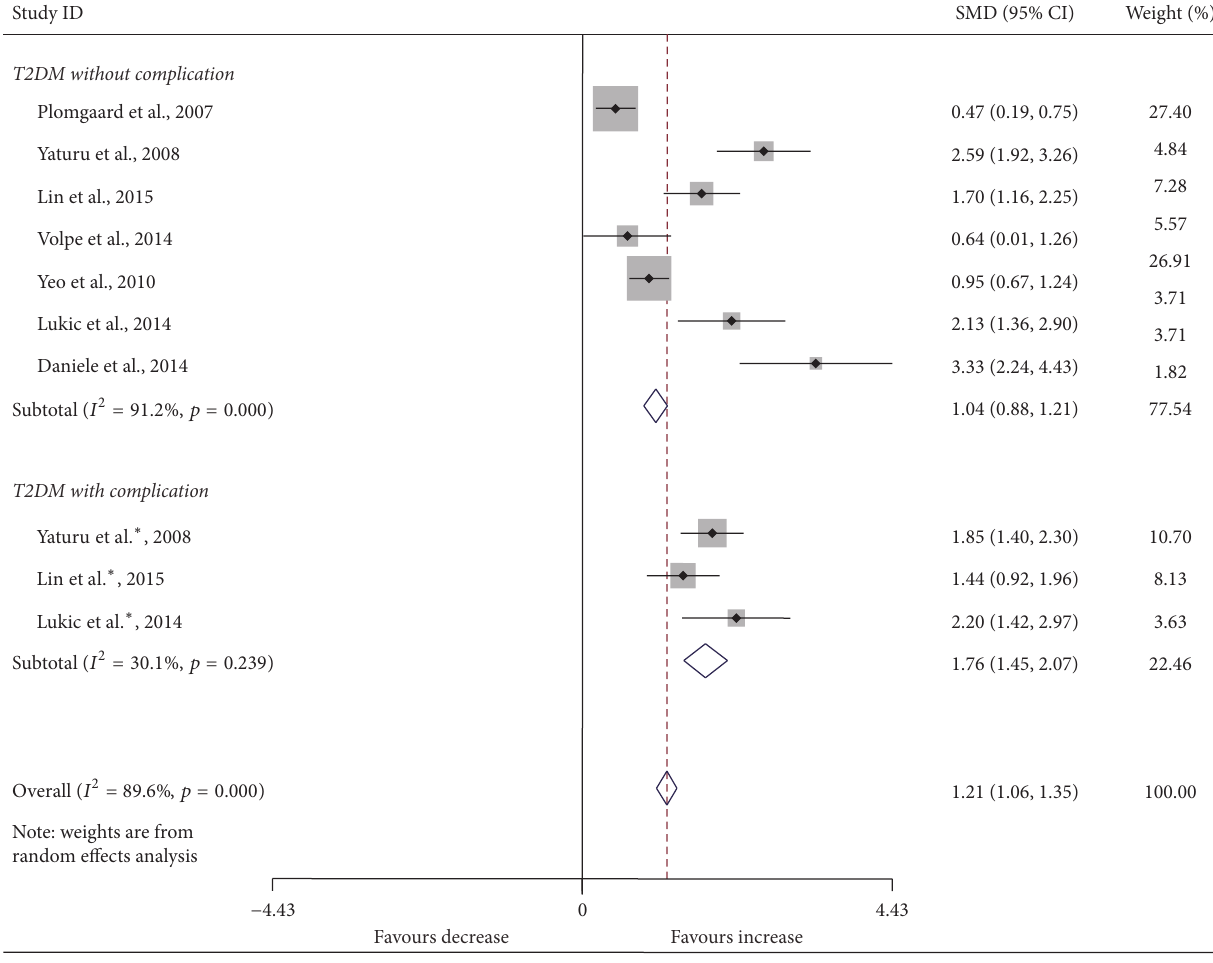
Figure 4: Forest plots for serum TNF- 𝛼 in T2DM patients and controls with random effects model (T2DM without complication, 𝑝 < 0.001 ; T2DM with complication, 𝑝 < 0.001 ; overall, 𝑝 < 0.001 ). ∗ T 2 DM with